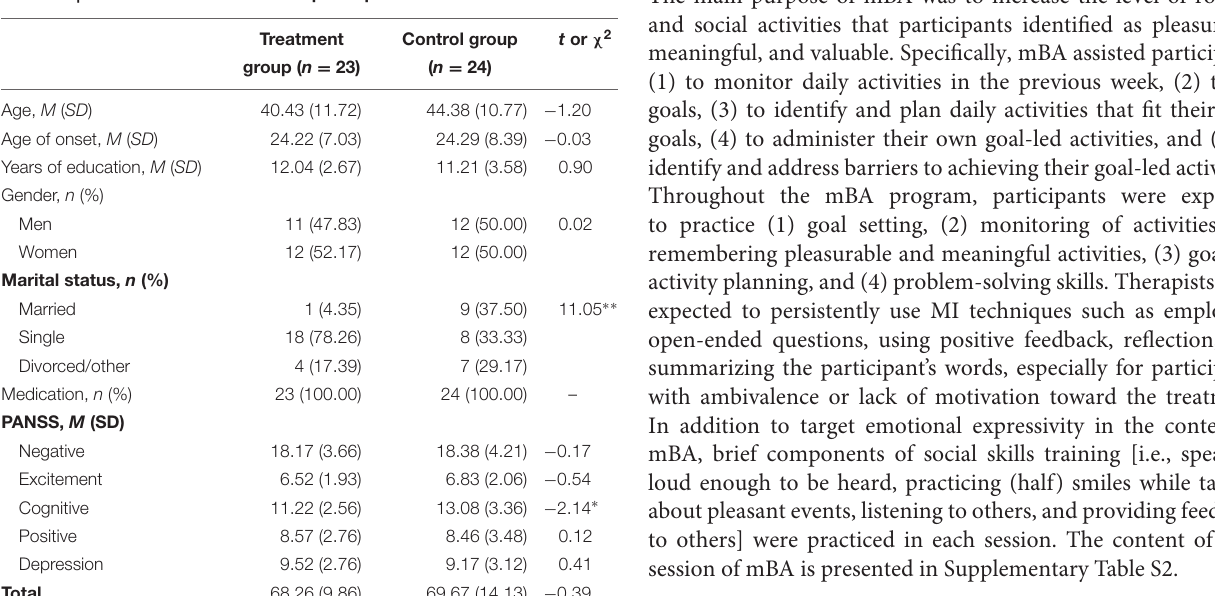
TABLE 1 | Baseline characteristics of participants.